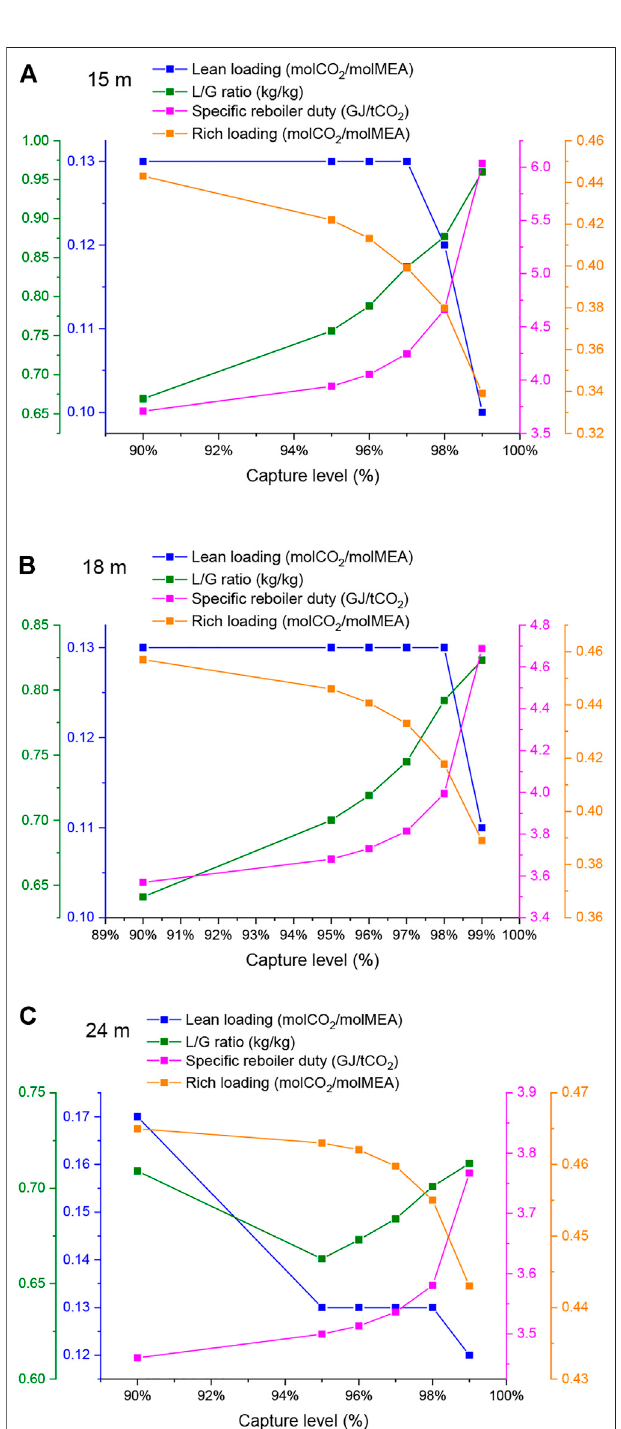
FIGURE 8 | General trends for several parameters at optimal operation at different absorber packing heights (a = 15 m, b = 18 m, c = 24 m) and varying capture